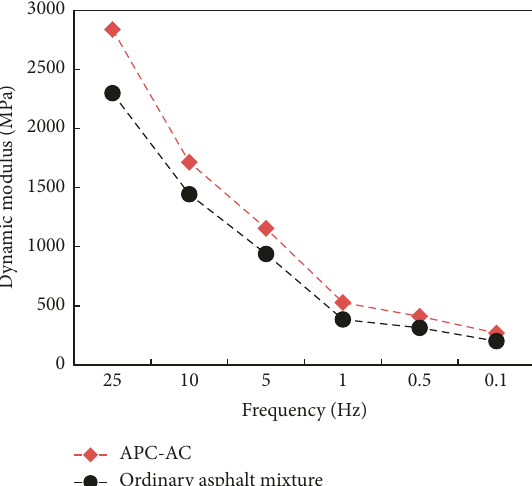
Figure 16: Results of dynamic modulus tests at 40 °